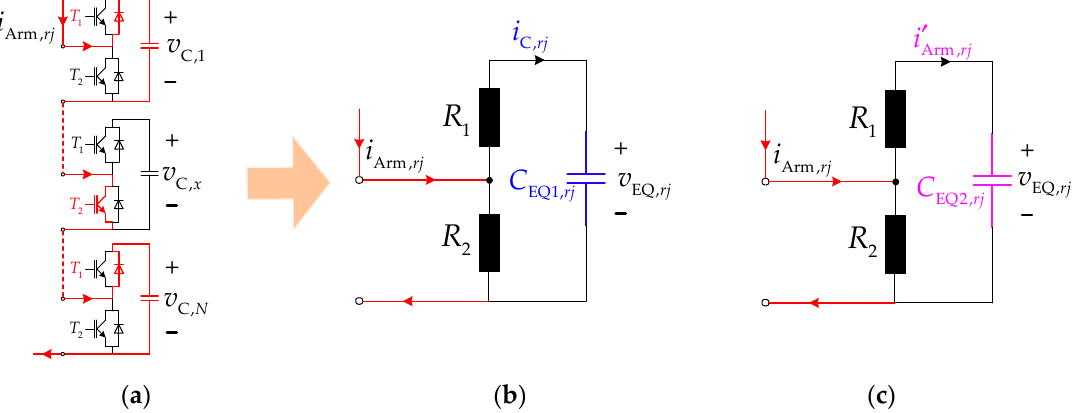
Figure 5. The arm equivalence: ( a ) The general structure of the arm; ( b ) The arm equivalent circuit based on average capacitor current; ( c ) The arm equivalent circuit based on arm current.